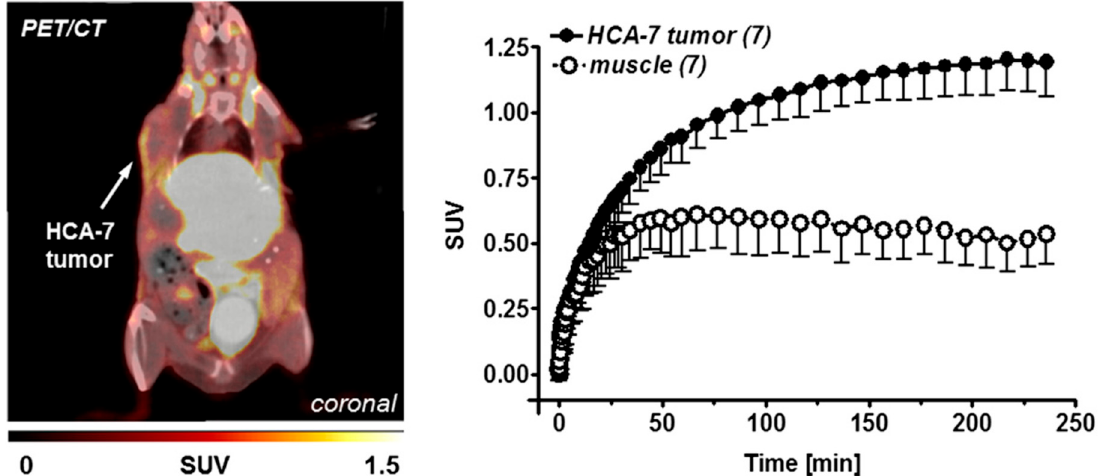
Figure 7. Left: PET/CT image (coronal slice) 2 h after injection of [ 18 F]Pyricoxib into an HCA-7-tumor-bearing NIH-III mouse. An amount of 3.5% HSA was added as a carrier protein to the final injection solution. Right: Time-activity curves for tumor uptake of [ 18 F]Pyricoxib and its clearance from muscle tissue over 4 h post injection. Data are shown as mean ± SD from seven dynamic PET experiments. Figure readapted with permission from publisher [78].